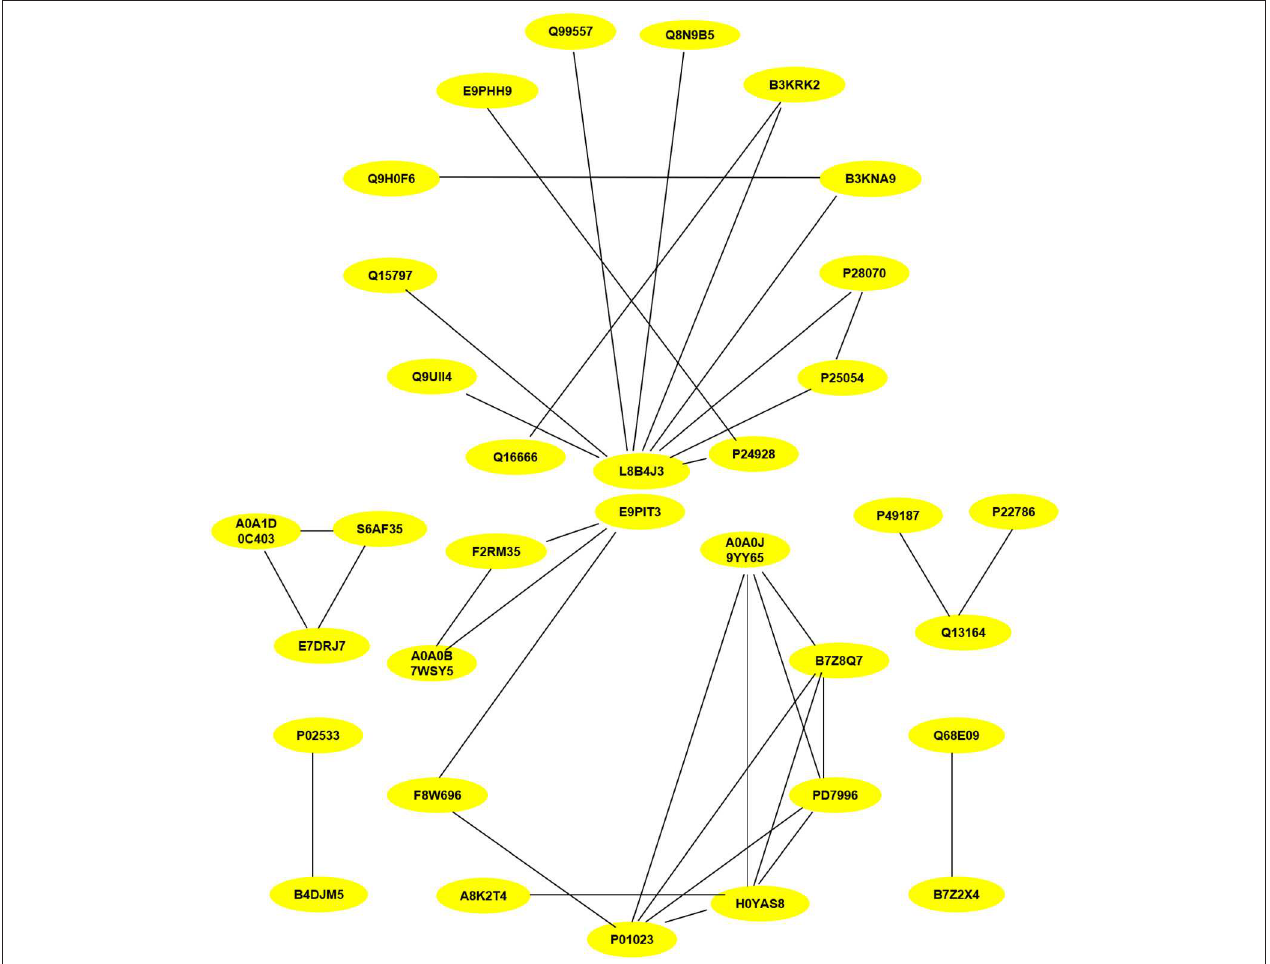
FIGURE 8 | Protein-protein interaction network of statistically differentially expressed proteins ( P < 0.05) associated with inflammation and fibrosis at 18h p.i. The proteins interconnectivity of two categories (inflammation and fibrosis) are shown. The yellow circles marked with symbols combining numbers and letters, represent the protein ID of differentially expressed proteins screened by comparison of TC0668 mut -infected and TC0668 wt -infected HeLa cells. The corresponding information of proteins can be analyzed via UniProt (https://www.uniprot.org/), each protein ID corresponds to a protein. For example, the protein ID “P01023” corresponds to the protein